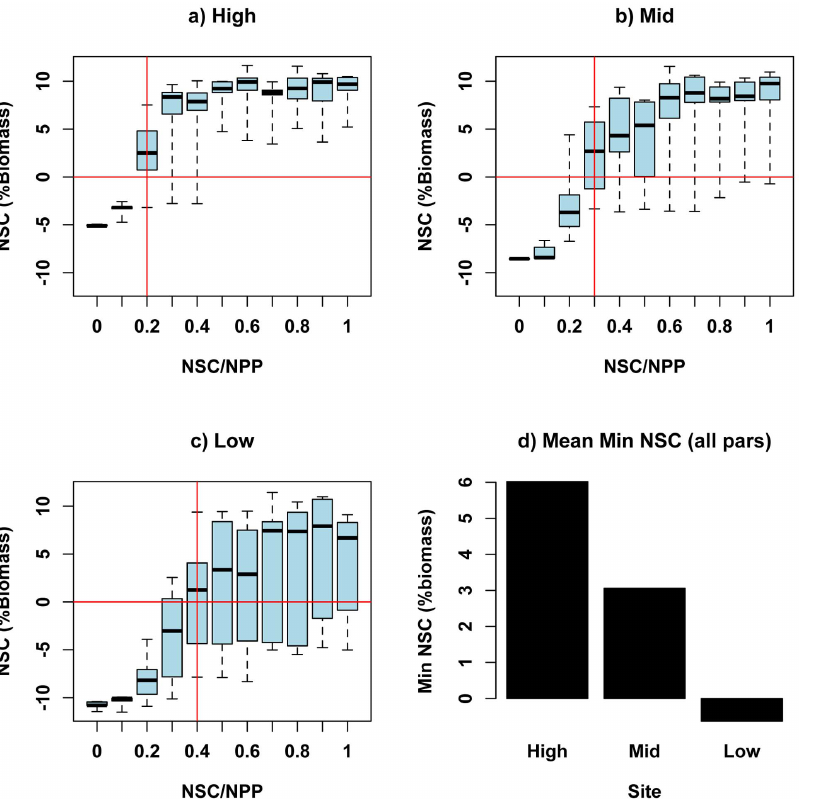
Figure 7. Estimates of minimum NSC as a percentage of biomass over 1992 – 2007 simulation period. Estimates of minimum NSC are shown for a tree of similar size for high, mid and low elevation sites. Horizontal lines denote values of NSC below which mortality is likely. Vertical lines denote the value of the NSC/NPP parameter for which minimum NSC is greater than zero for most values (3 rd quartile) of MinL/AGC . Graphs show variation in minimum NSC across variation in parameters: NSC/NPP (x-axis) and MinL/AGC (box widths). Bottom right graph shows average value of minimum NSC across all parameters for high, mid and low elevation site. Initial structural carbon values are the same for all three sites.